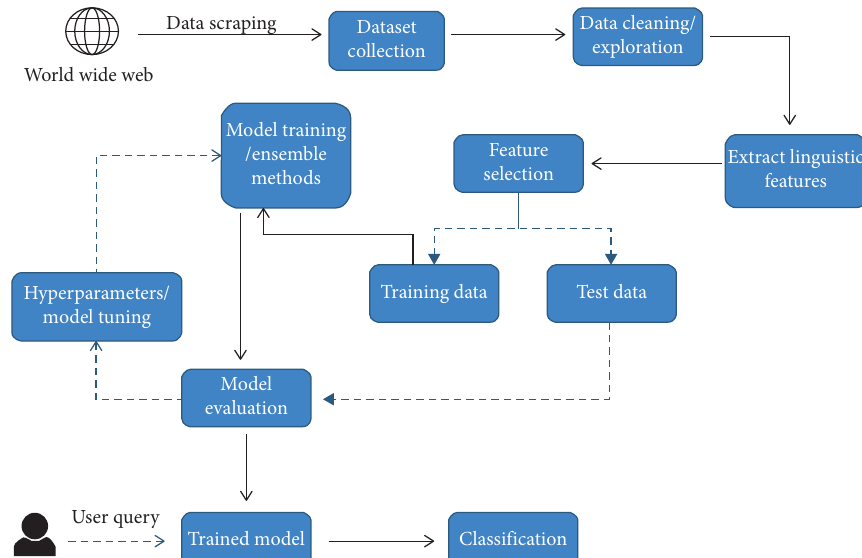
Figure 1: Workflow for training algorithms and classification of news